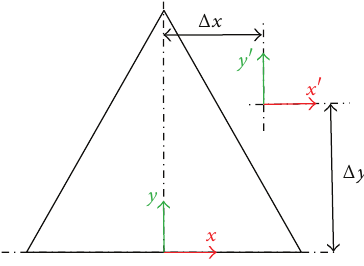
Figure 5: Change in the coordinate